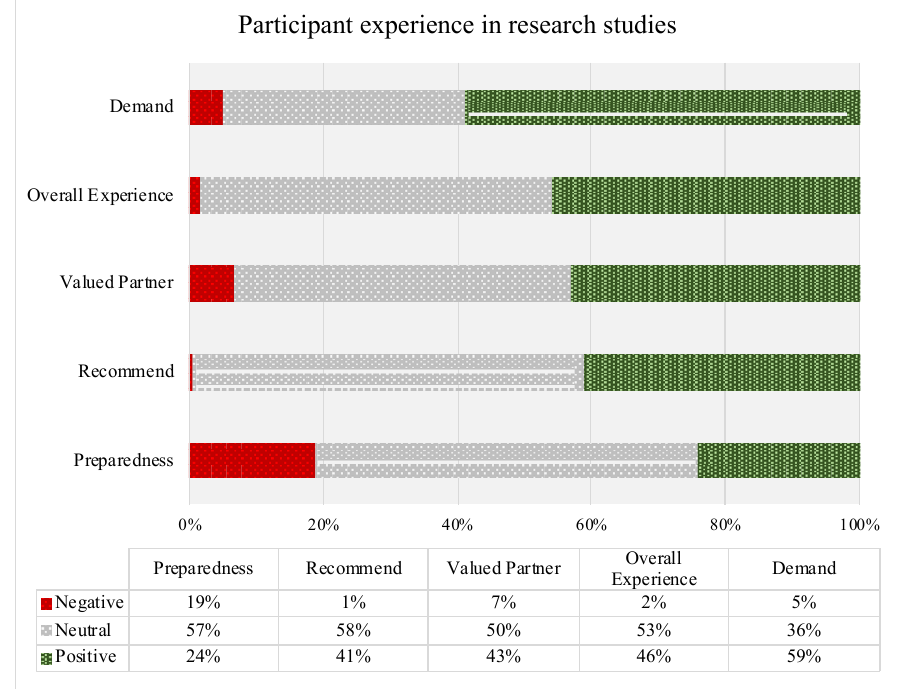
Figure 8. Overall Research Experience, Burden, and Preparedness.